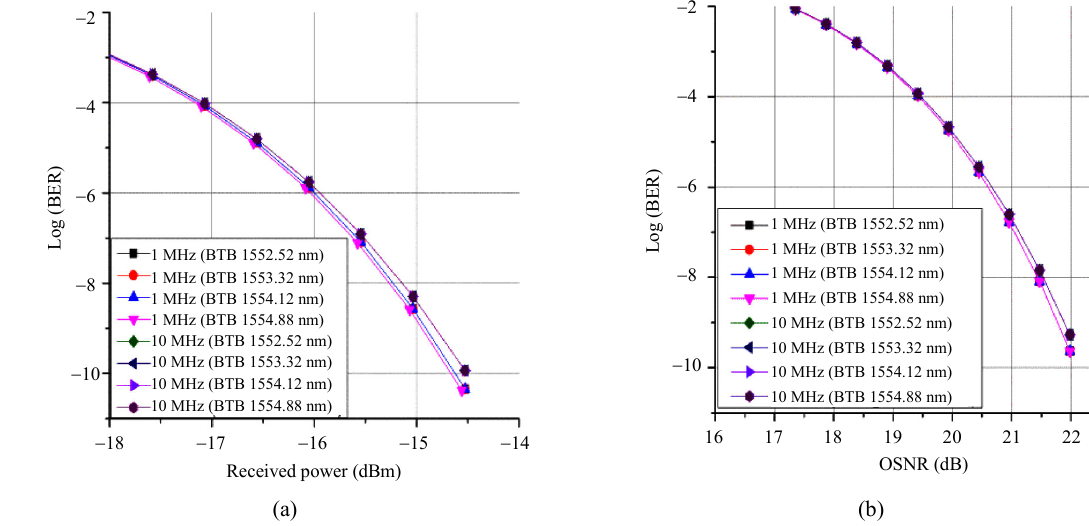
Fig. 5 Effects of payload’s laser linewidth on WDM channels: (a) BER vs. ROP and (b) BER vs. OSNR.